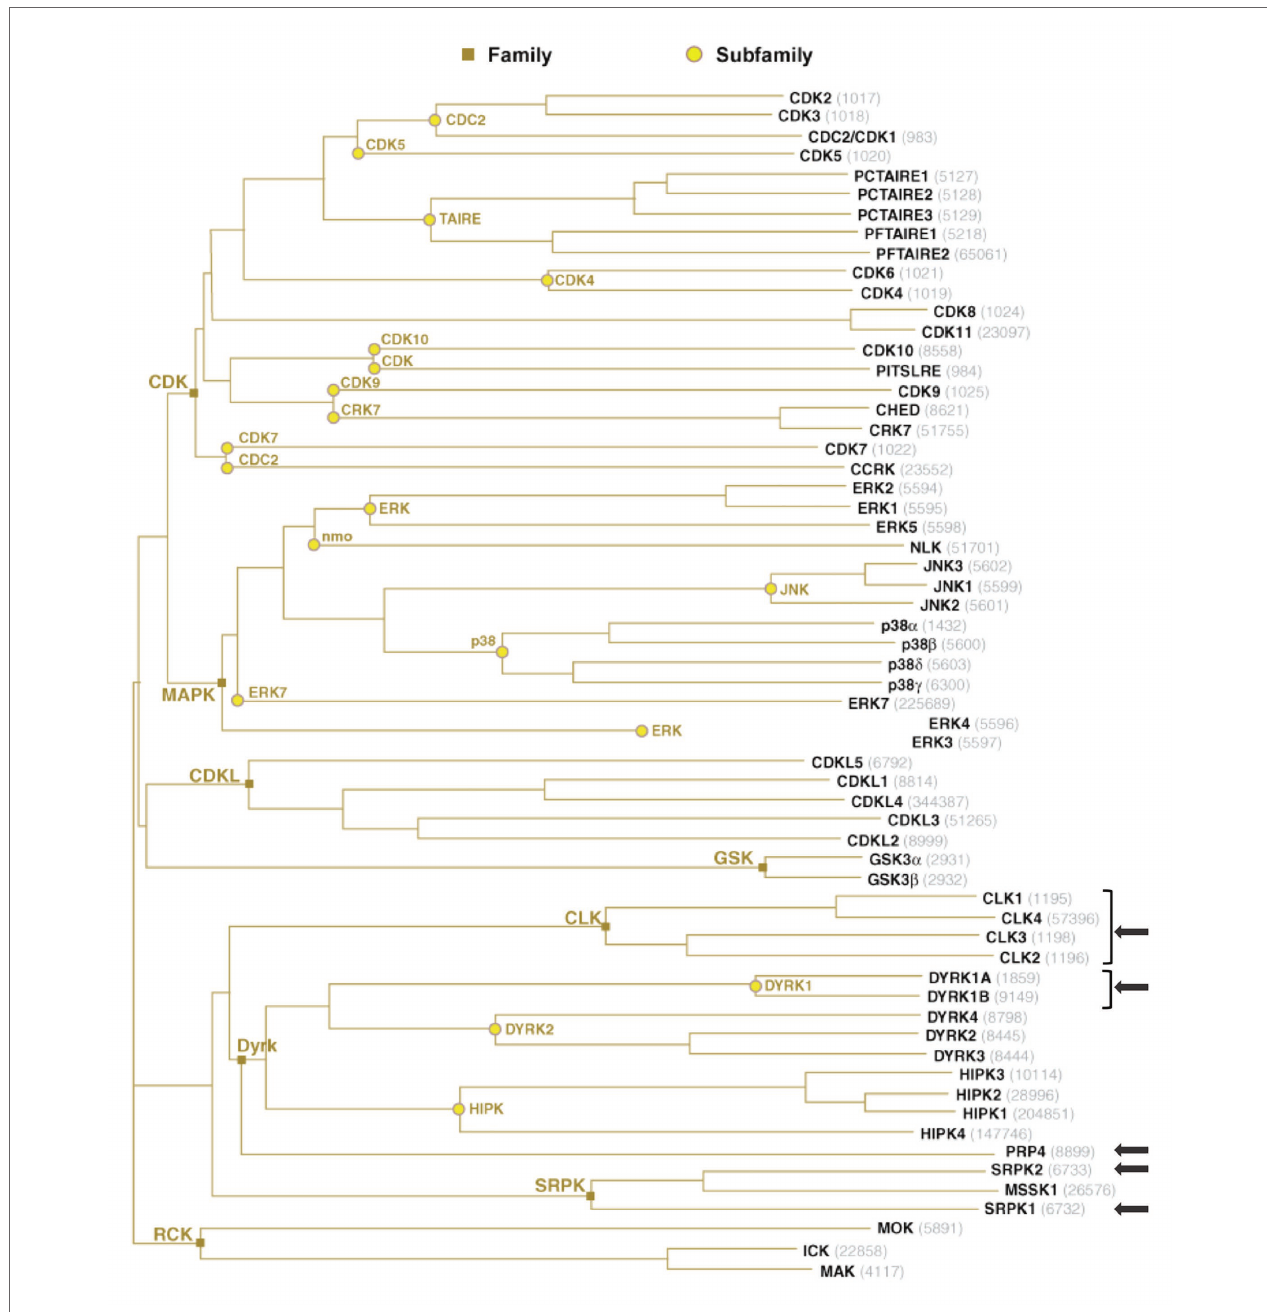
FIGURE 3 | The group of human CMGC kinases. Of the 518 human protein kinases, 61 belong to the CMGC group and can be clustered into eight families and several sub-families of increasing sequence similarity and biochemical function. The unrooted kinase dendrogram shows the sequence similarity between the catalytic domains of the CMGC kinases: the distance along the branches between two kinases is proportional to the divergence between their sequences. Arrows indicate the kinases in SR proteins phosphorylation. NCBI accession number are indicated in gray. Illustration reproduced courtesy of Cell Signaling Technology, Inc.